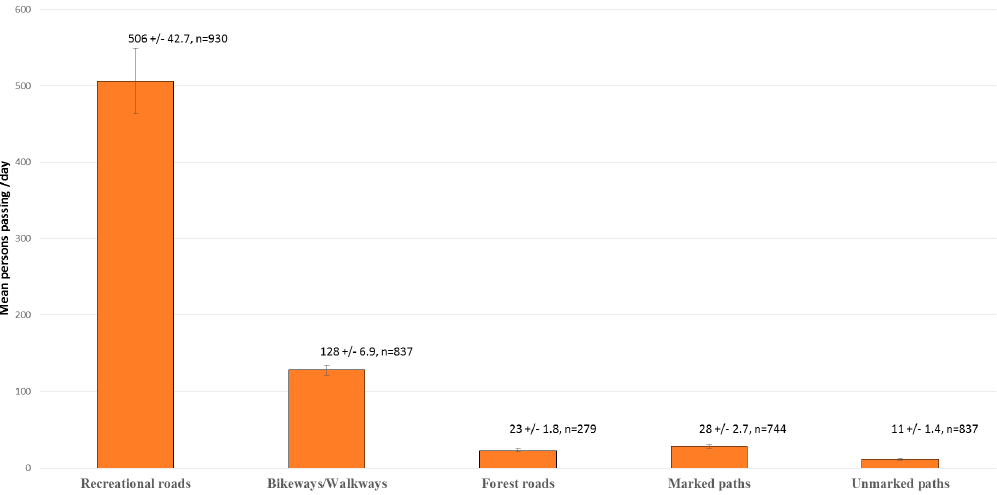
Figure 4. Mean number of persons passing per day during 94 days in the months July, August and September along the recreational infrastructure continuum, documented at 39 counting sites in urban areas in southeastern Norway. Legend: Mean value ± 2 Standard Error. See Table 4 for counting sites details.